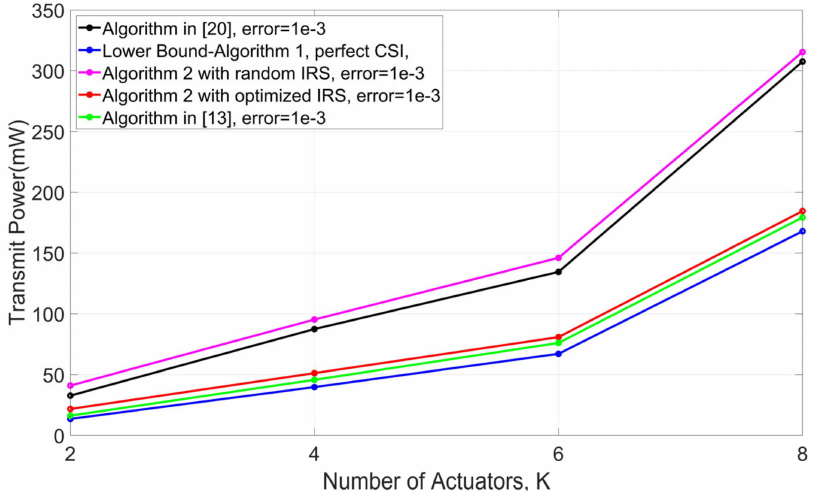
Figure 5. The effectiveness of the proposed algorithm under different numbers of the actuators.